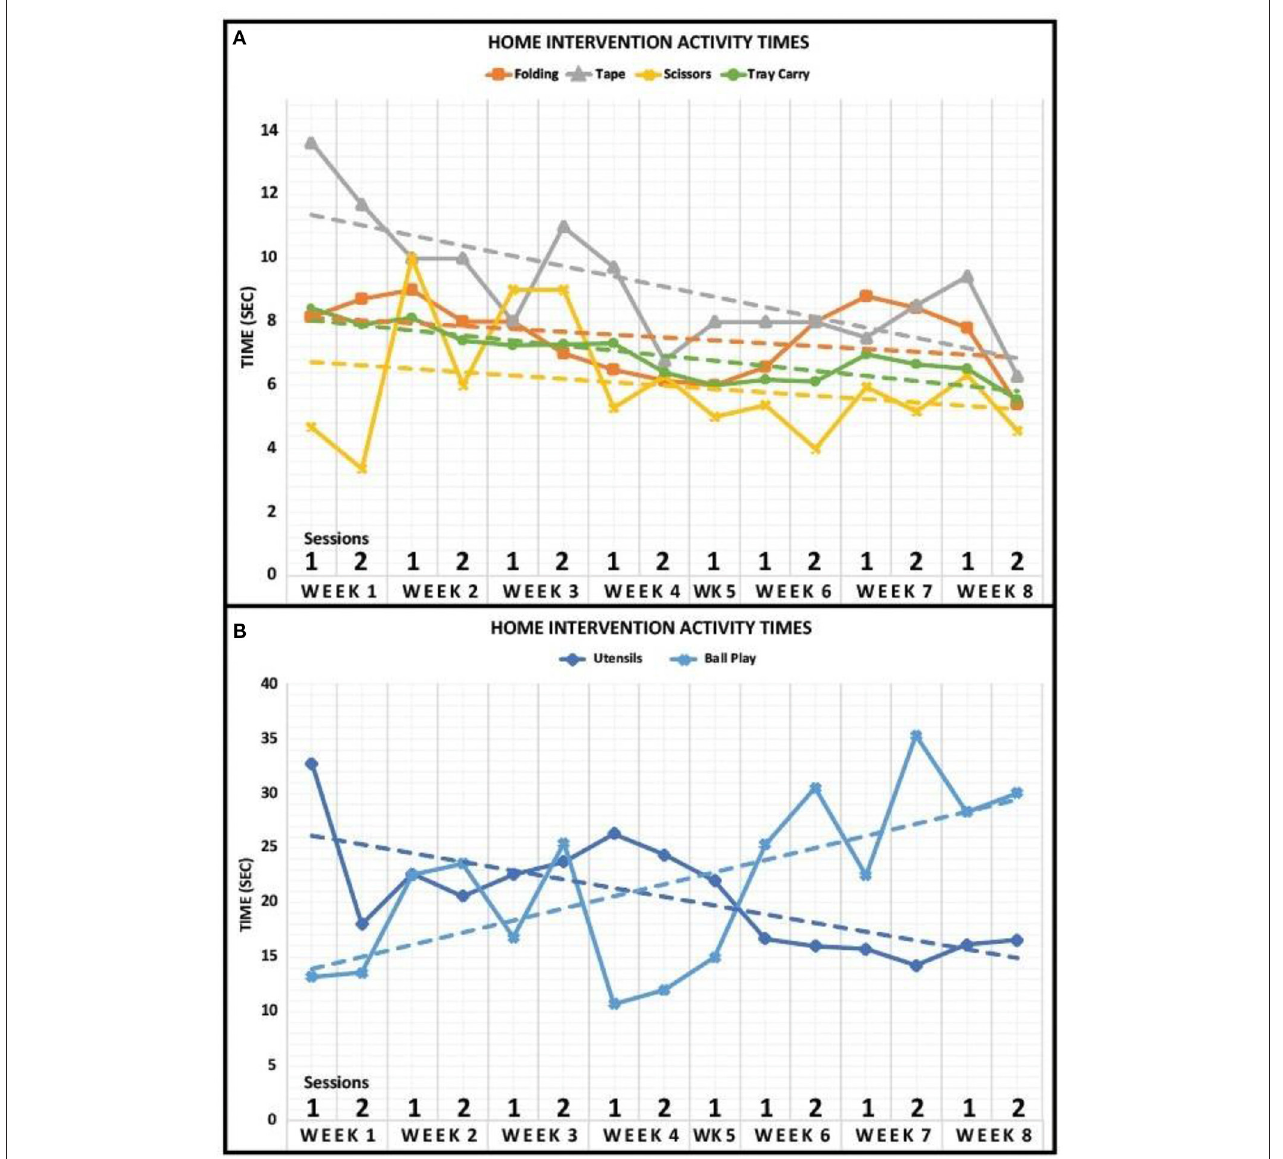
FIGURE 3 | Home intervention activity times. (A) Activity times for Folding, Tape, Scissors, and Tray Carry are displayed for 8 weeks. The case participant completed both sessions for every week of the home intervention training except for week 5. Dashed lines represent a linear fit of the data. (B) Activity times for Utensils and Ball Play are displayed for 8 weeks. The case participant completed both sessions for every week of the home intervention training except for week 5. Dashed lines represent a linear fit of the data.